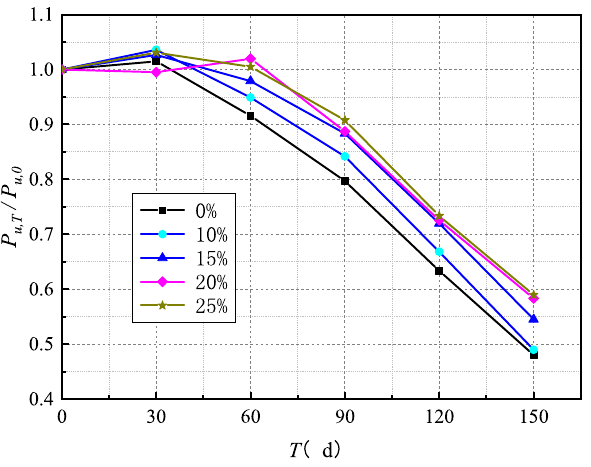
Figure 6. Effect of fly ash content on stripping bearing